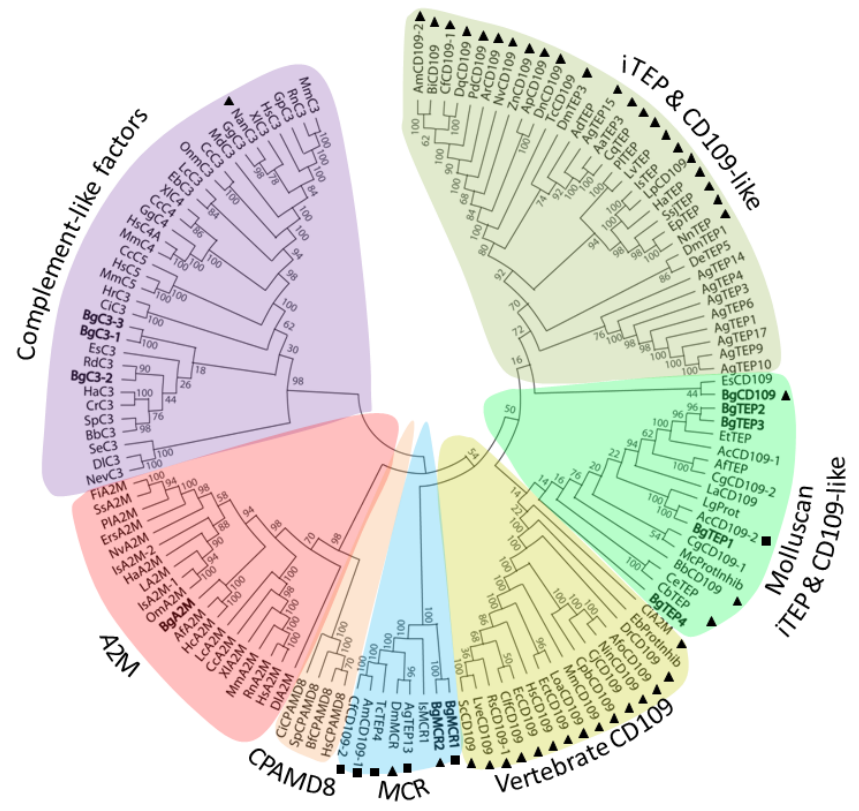
Figure 1. Phylogenetic tree of various thioester-containing protein (TEP) superfamily members. A total of 134 full-length protein sequences from diverse animal origin were used to construct the tree. A bootstrap analysis of 1000 replications was carried out on the tree inferred from the maximum likelihood method and the values are shown at each branch of the tree. BgTEPs are indicated in bold characters. Black triangles correspond to predicted glycosylphosphatidylinositol (GPI)-anchor signal, while black square corresponds to C-terminal transmembrane helix. TEP subgroups are highlighted by different colors: Purple for complement-like factors, pink for A2M, orange for CPAMD8, blue for MCR, and shades of green for iTEP and CD109-like. TEP molecules from B. glabrata belong to four clades of the TEP superfamily, and were named according to the actual nomenclature: (1) Complement-like factors (BgC3-1, BgC3-2, and BgC3-3), (2)